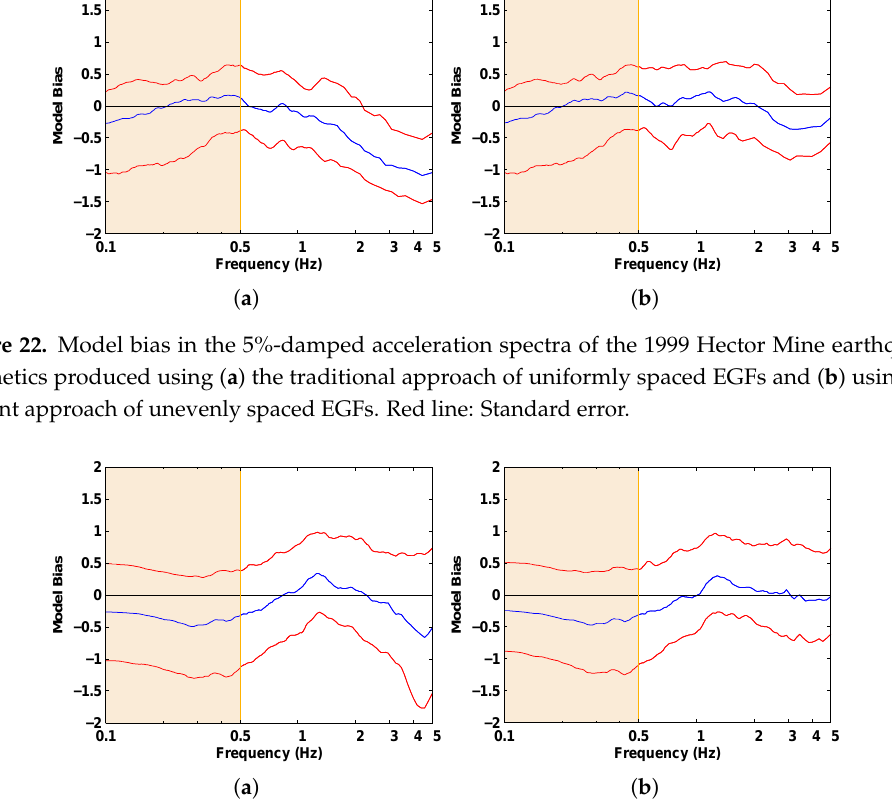
Figure 23. Model bias in the 5%-damped acceleration spectra of the 2004 Parkfield earthquake synthetics produced using ( a) the traditional approach of uniformly spaced EGFs and ( b ) using the present approach of unevenly spaced EGFs. Red line: Standard